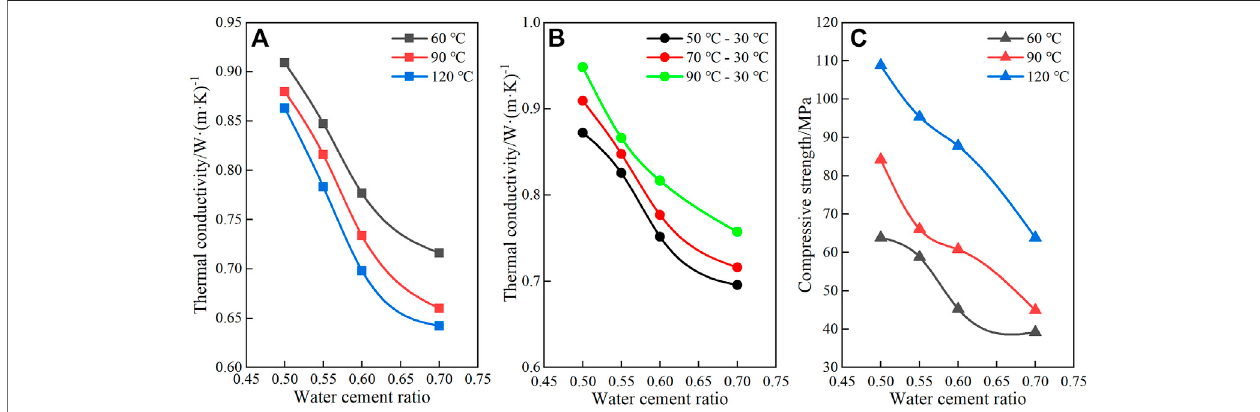
FIGURE 4 | Thermal conductivity and compressive strength test results of pure cement under different conditions. (A) Test results of thermal conductivity at different curing temperatures. The test temperature combination is 70 – 30 ° C. (B) Test results of thermal conductivity at different hot plate temperatures. The curing temperature is 60 ° C. (C) Test results of compressive strength at different curing temperatures.